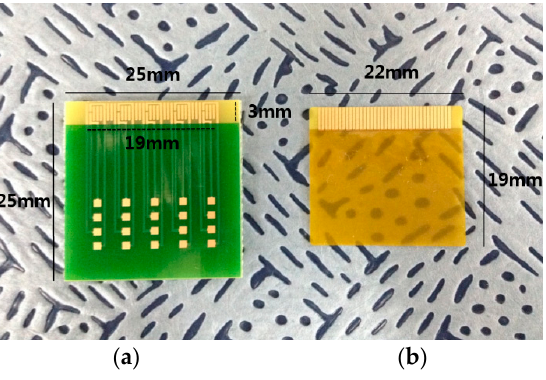
Figure 5. 500- μ m-pitch flex-on-board (FOB) test vehicles. ( a ) printed circuit board (PCB), ( b ) polyimide based flexible printed circuit (FPCB).